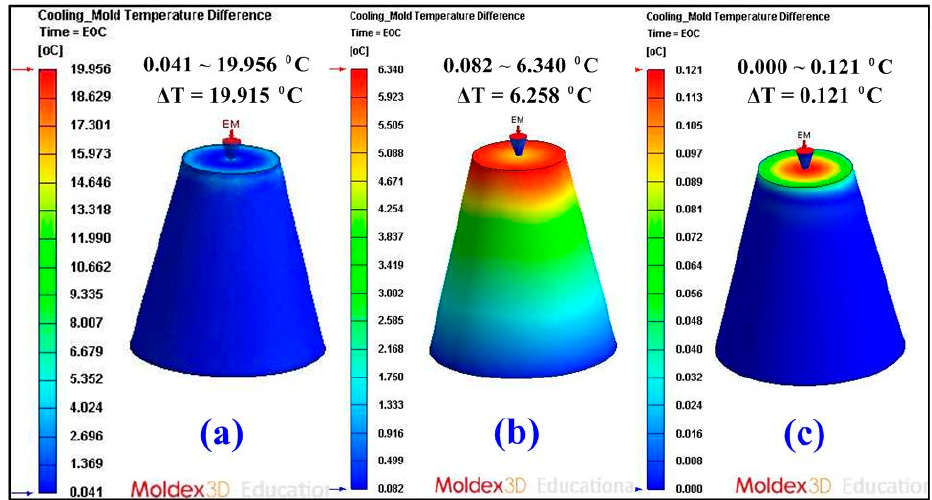
Figure 12. Numerical simulation results of part temperature difference for injection molds ( a ) without cooling channel, ( b ) with conventional cooling channels, and ( c ) with optimum conformal cooling channels (CCCs).